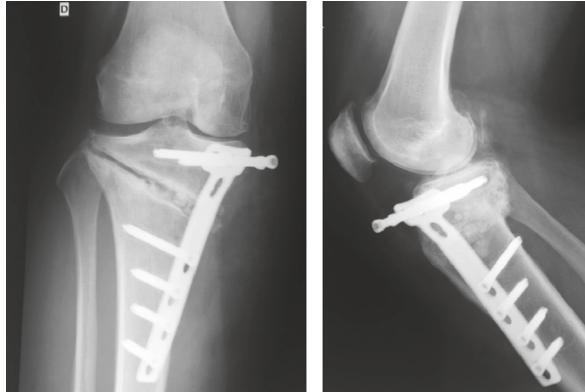
Figure 2: Postoperative X-rays showing fracture of the lateral cortex at the osteotomy site.